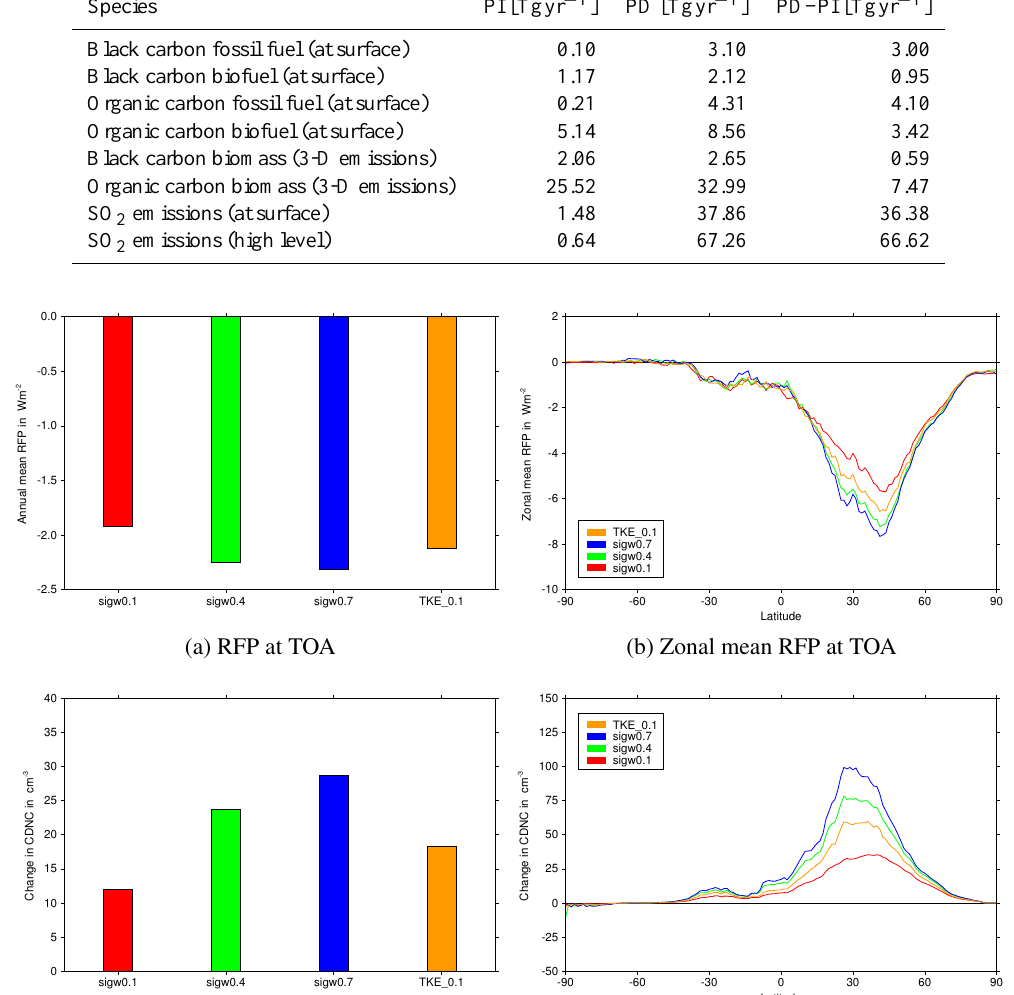
Table 4. Global emissions from anthropogenic sources for each species considered in this study, for pre-industrial (PI) and present-day (PD) simulations. Emissions for the years 1850 and 2000 are taken from the Coupled Model Intercomparison Project Phase 5 (CMIP5) emissions data set (Lamarque et al., 2010).